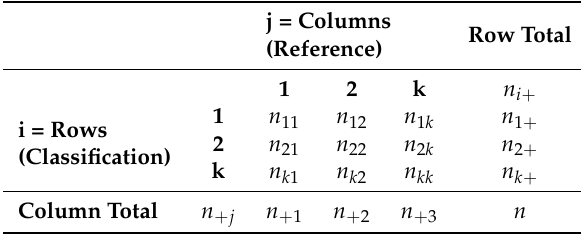
Table 2. Mathematical formulation of the error